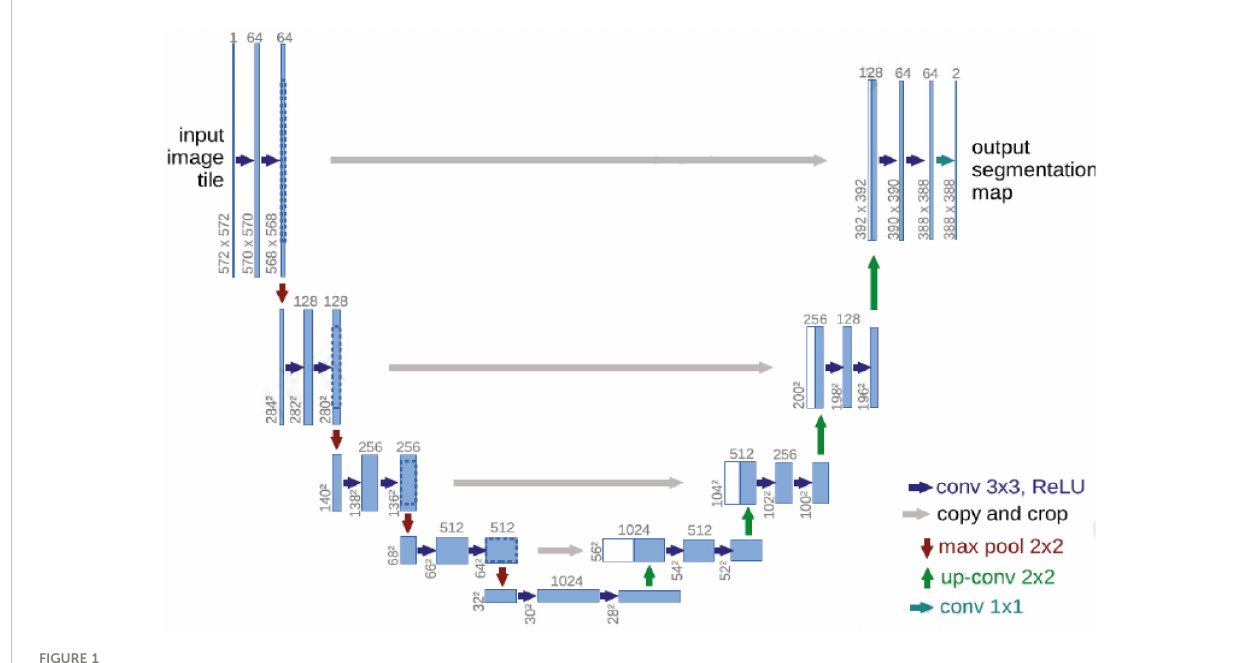
FIGURE 1 Schematic diagram of the U-Net (15) network